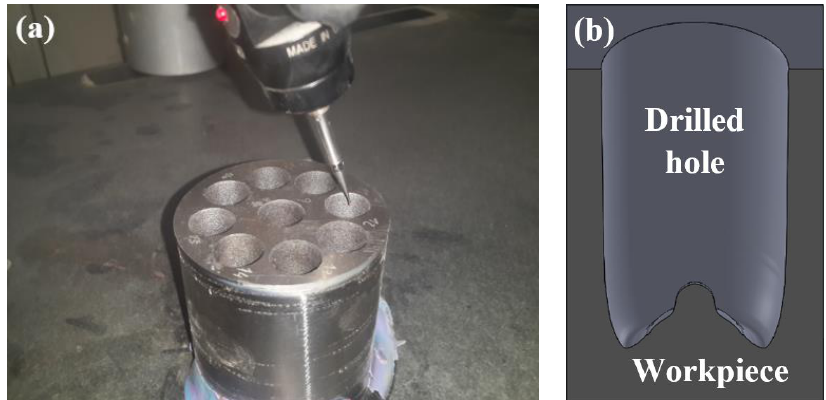
Figure 5. ( a ) The characterization of the machined cavities using Aberlink Coordinate Measuring Machine and ( b ) the 3-D geometry by Solidworks.